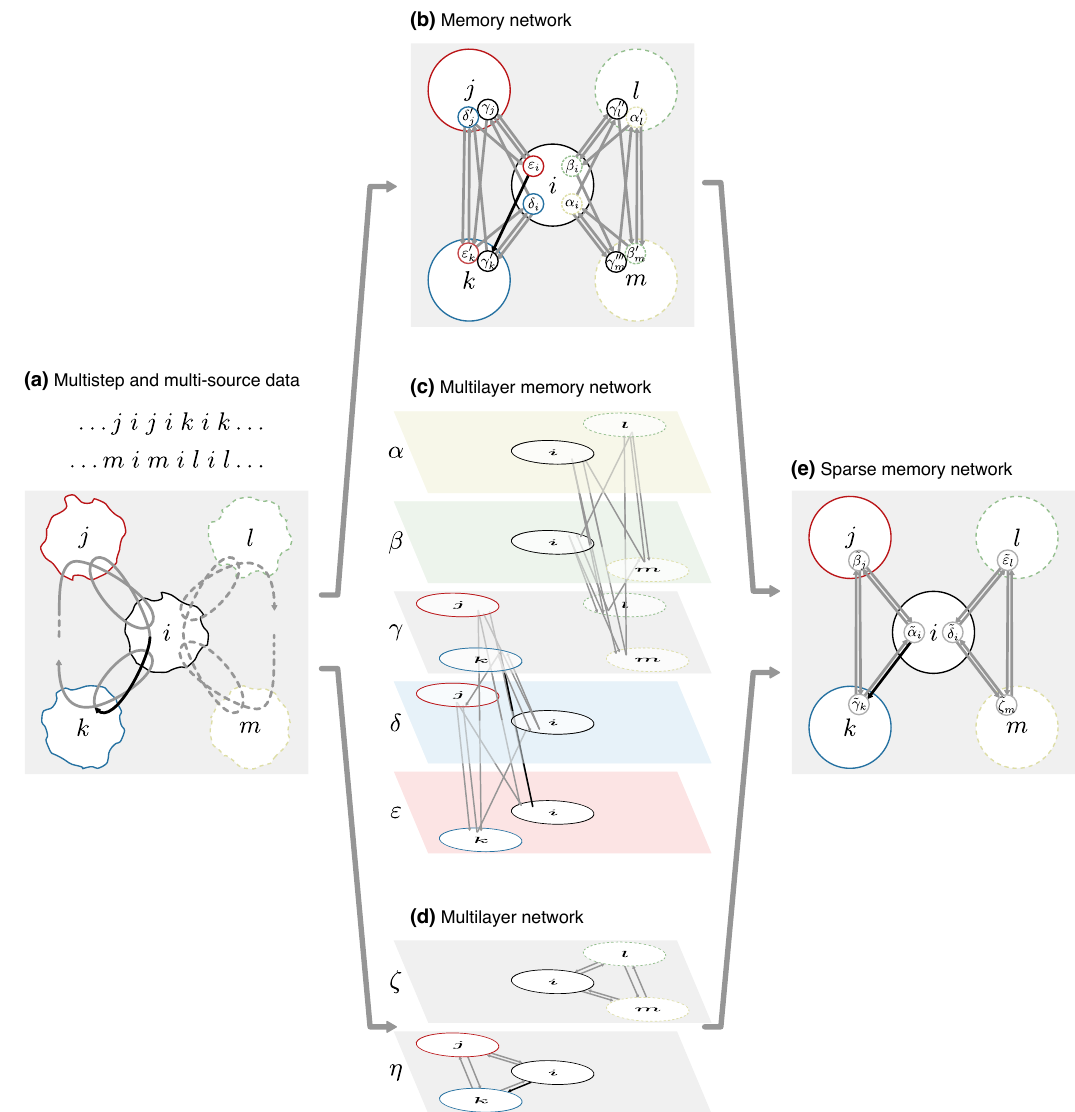
Figure 2. Modeling higher-order network flows with sparse memory networks. ( a ) Multistep pathway data from two sources illustrated on a network with five physical nodes; ( b ) The pathway data modeled with a second-order Markov model on a memory network, where state nodes capture where flows come from; ( c ) The memory network represented as a multilayer network where layers, one for each physical node, capture where flows come from; ( d ) The pathway data modeled on a two-layer network, one layer for each data source; ( e ) Both memory and multilayer networks mapped on a sparse memory network with no redundant state nodes. The black link highlights the same step in all